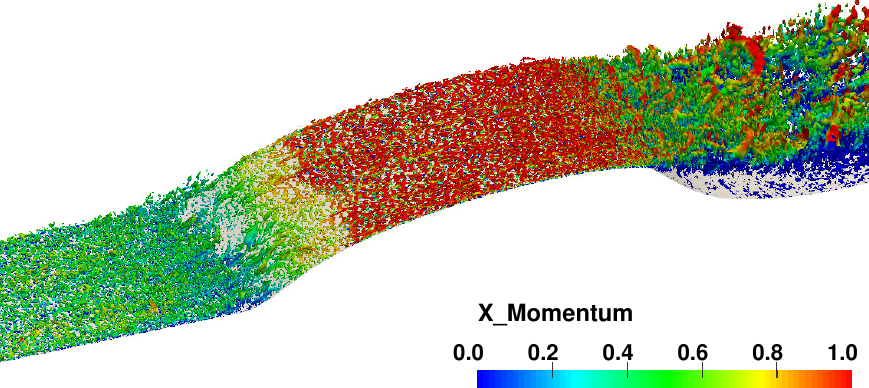
Figure 14. WA-WMLES of NASA hump flow: instantaneous Q-criterion isosurfaces colored by streamwise momentum.